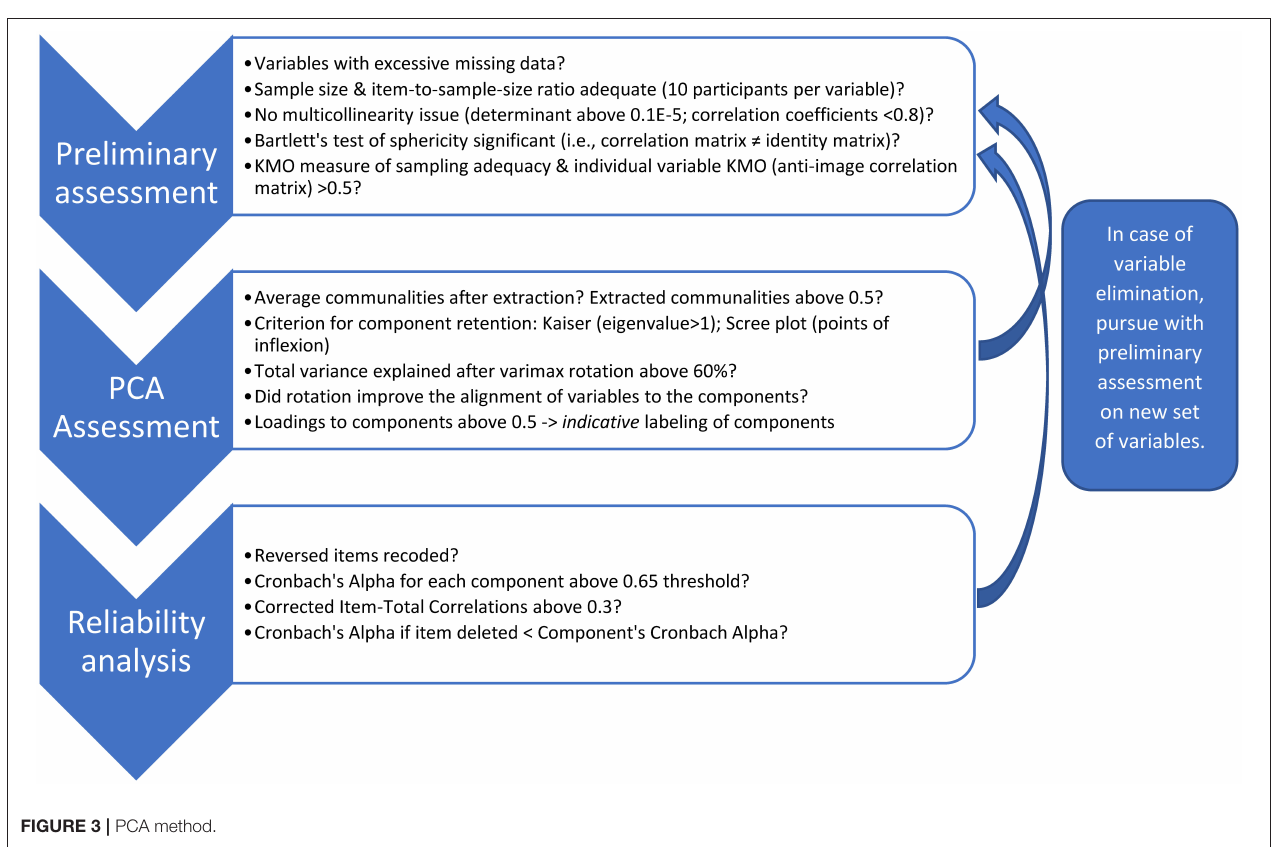
FIGURE 3 | PCA method.